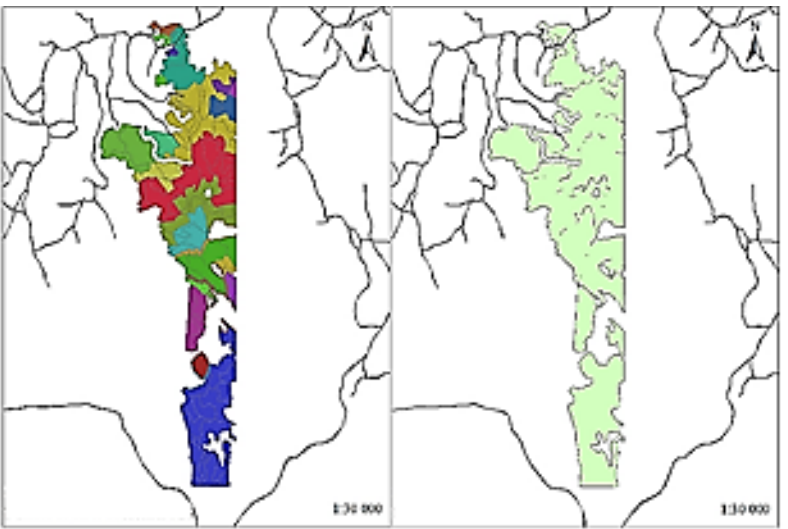
Figure 2. An example of harvesting blocks before ( left ) and after aggregation by area ( right ) with the aggregation tool FPInterface TM .